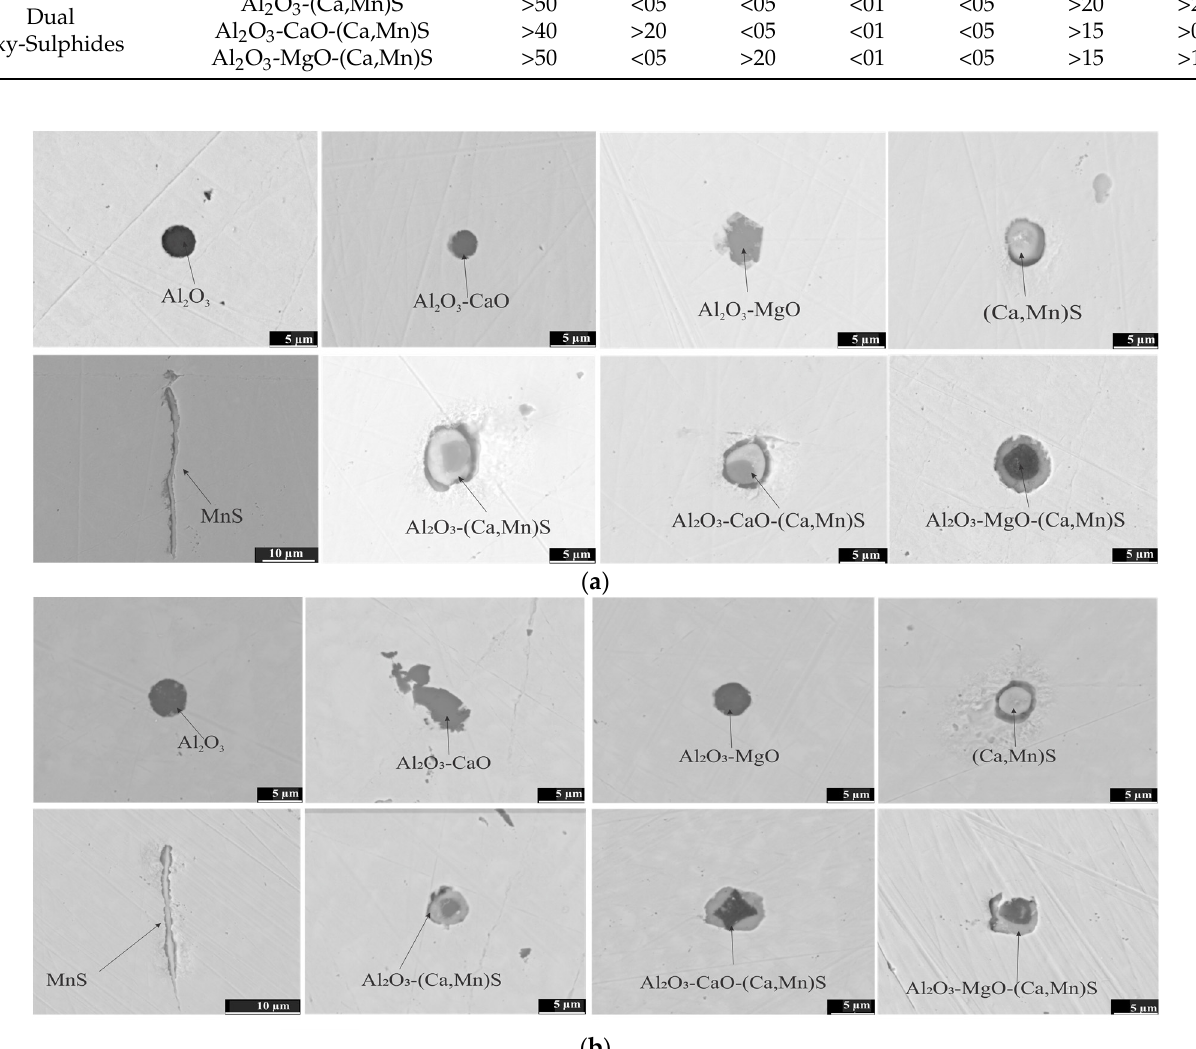
Figure 1. Typical morphology and composition of inclusions in both samples. ( a ) GS1 sample, ( b ) GS2 sample.